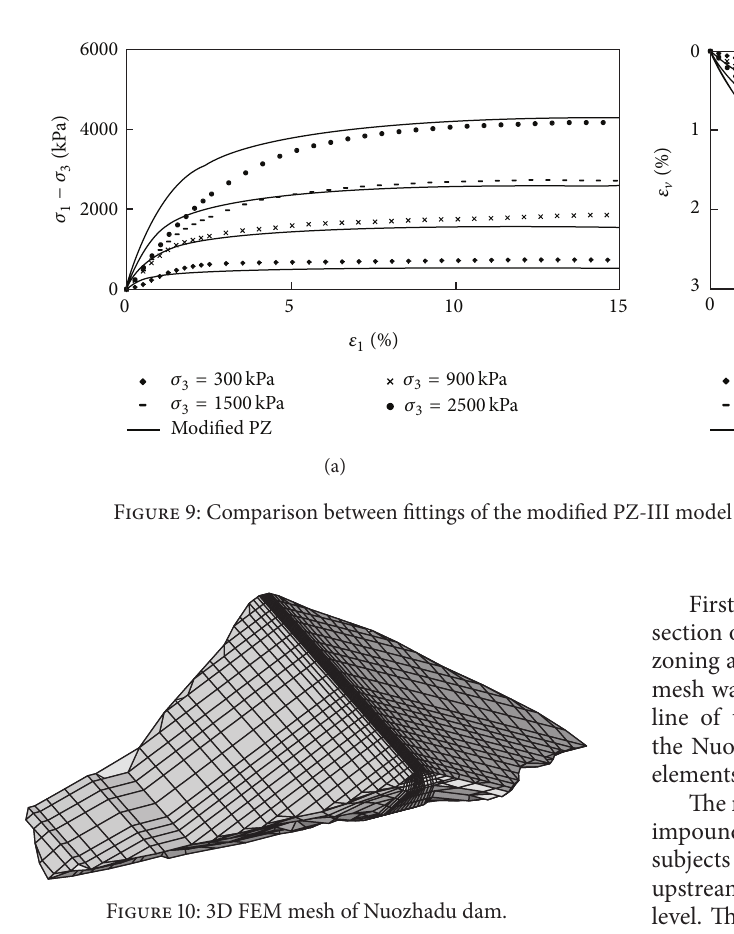
Figure 8: Comparison between fittings of Duncan and Chang’s EB model and experimental triaxial tests results for clay.